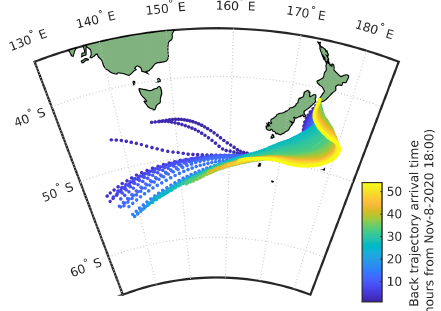
Figure B5. Air mass back trajectories over the past 72h for time from 8 November at 18:00 to the end of 10 November 2020 coloured by arrival time at the